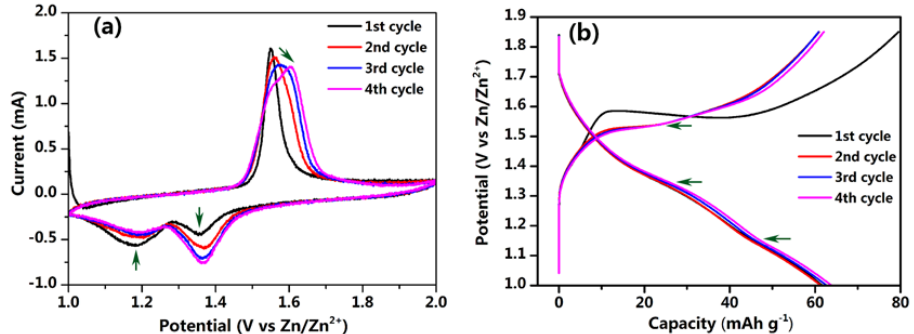
Figure 6. Electrochemical performance of the Na 4 Mn 9 O 18 ‐ RGO electrode (vs. Zn/Zn 2+ ). ( a ) CV curves at a rate of 0.1 mV ∙ s − 1 . ( b ) Charge and discharge curves at 4 C.